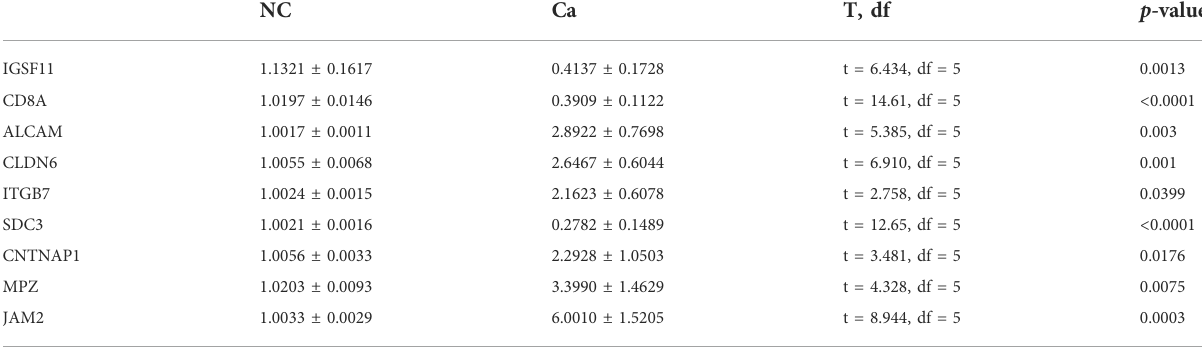
TABLE 3 The qRT-PCR result of model genes in cancer and normal